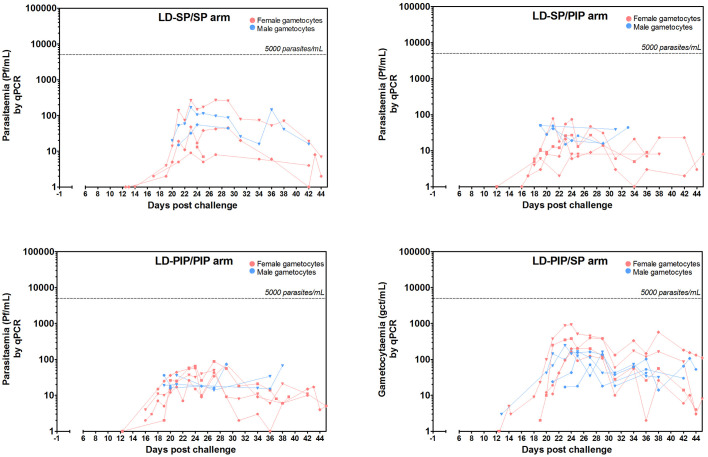
Female and male gametocytes per study arm.